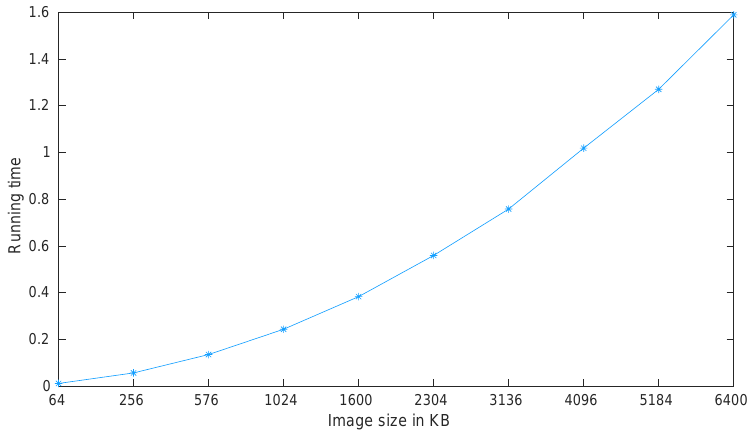
Figure 6. The running times for encrypting images of different sizes.